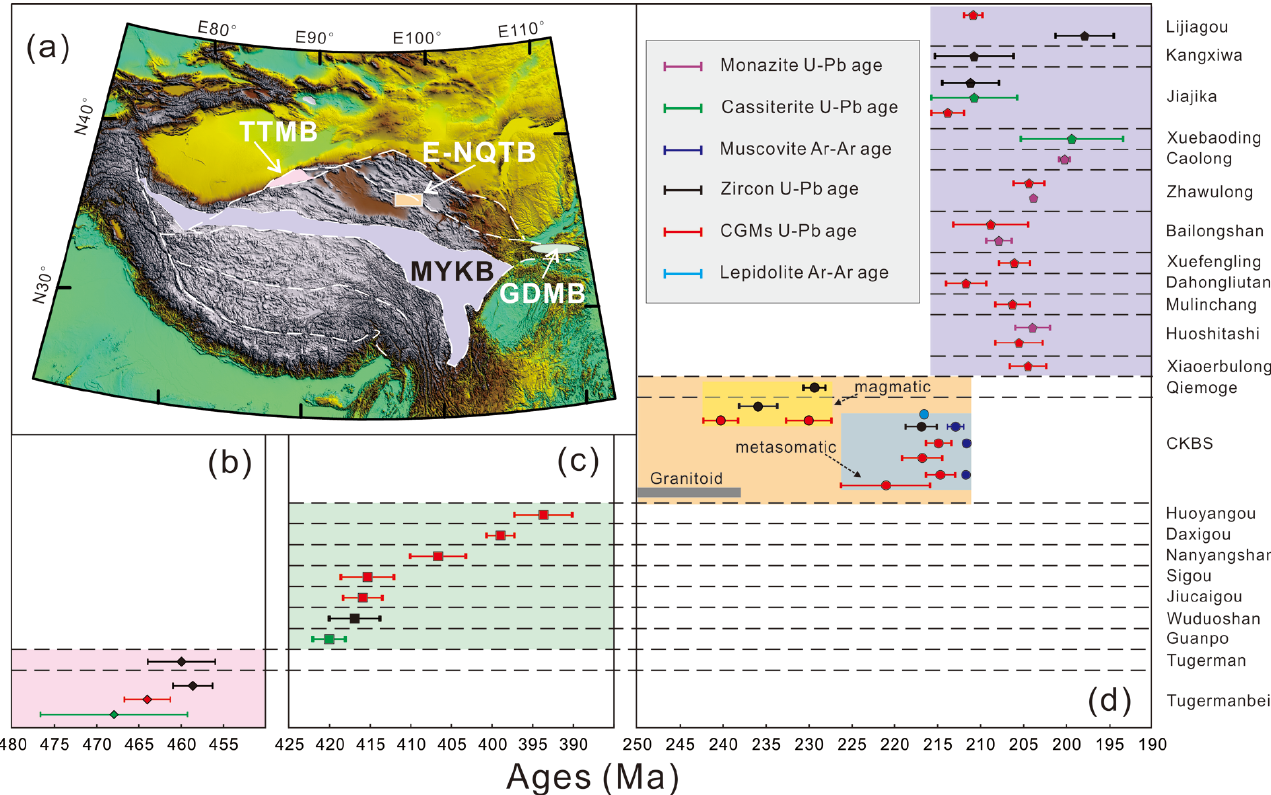
Figure 10. Comparison of geochronological data of the pegmatite-type rare-metal deposits in the TTMB, GDMB, E-NQTB and MYKB. ( a ) Topographic map showing the distributions of the rare-metal mineralized belts around the CKBS deposit in the eastern NQTB (modified after Zhan et al. [88], Zhang et al. [89] and Robinson [90]). ( b ) the dating results for the TTMB (Tugman-Tashisayi mineral- ization belt, pink area). ( c ) the dating results for the GDMB (Guanpo-Danfeng mineralization belt, laurel-green area). ( d ) the dating results for the E-NQTB (the eastern North Qaidam Tectonic Blet, saffron yellow area) and the MYKB (Markam-Yajiang-Karakoram belt, purple area). Yellow area and light grey area in ( c ) represent the ranges for crystallization ages and metasomatic ages of pegmatites in the eastern NQTB, respectively. Detailed data and sources are shown in Table 3. This diagram does not include the muscovite Ar-Ar ages of the Aketasi, Dangba and Tugmanbei deposits due to their far difference from the results of other geochronological methods. Meanwhile, due to the large error values ( ± 8, MSWD = 6.7, Li et al. [23]), the cassiterite U-Pb age for the 505 Li is also ruled out. The ages of Triassic granitoids (grey area) in the eastern NQTB are from Wu et al. [91] and Sun et al.